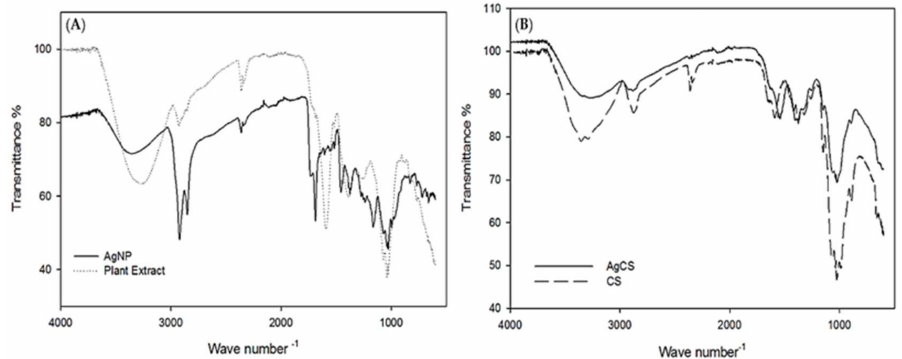
Figure 3. FTIR analysis of ( A ) synthesized AgNPs and plant extract of L. lucidum ( B ) of pure CS and AgCS.